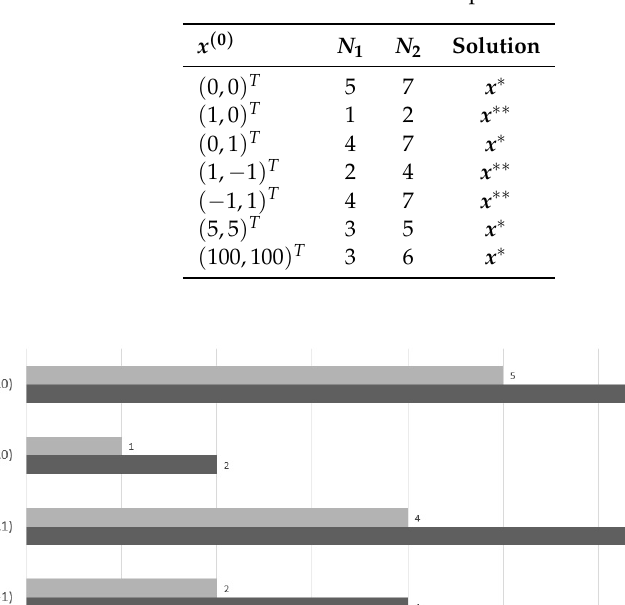
Table 2. Results for Example 2.